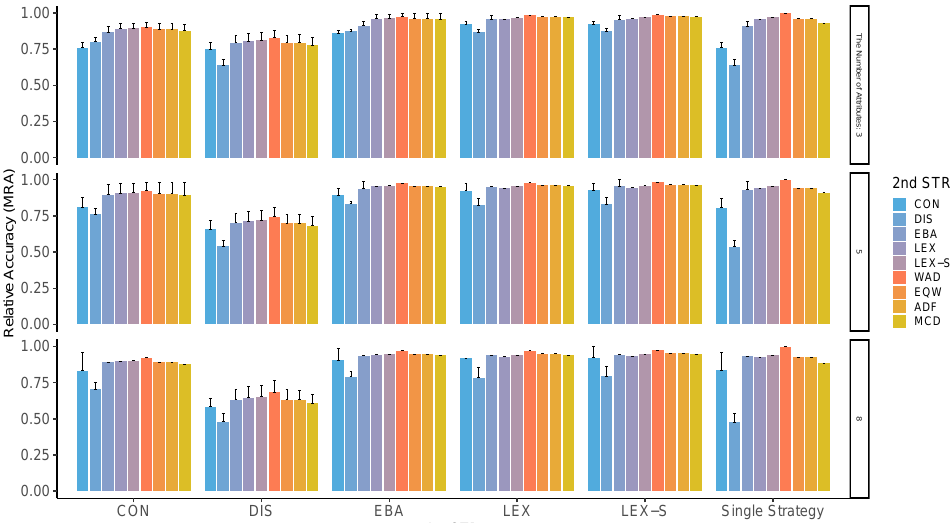
Figure A7. MRA in two-stage decision-making when only two alternatives are left in the second stage for the different numbers of attributes. ADF: additive difference; CON: conjunctive; DIS: disjunctive; EBA: elimination by aspects; EQW: equal-weighted strategy; LEX: lexicographic; LEX-S: lexicographic semi-order; MCD: majority of confirming dimensions; STR: strategy; WAD: weighted